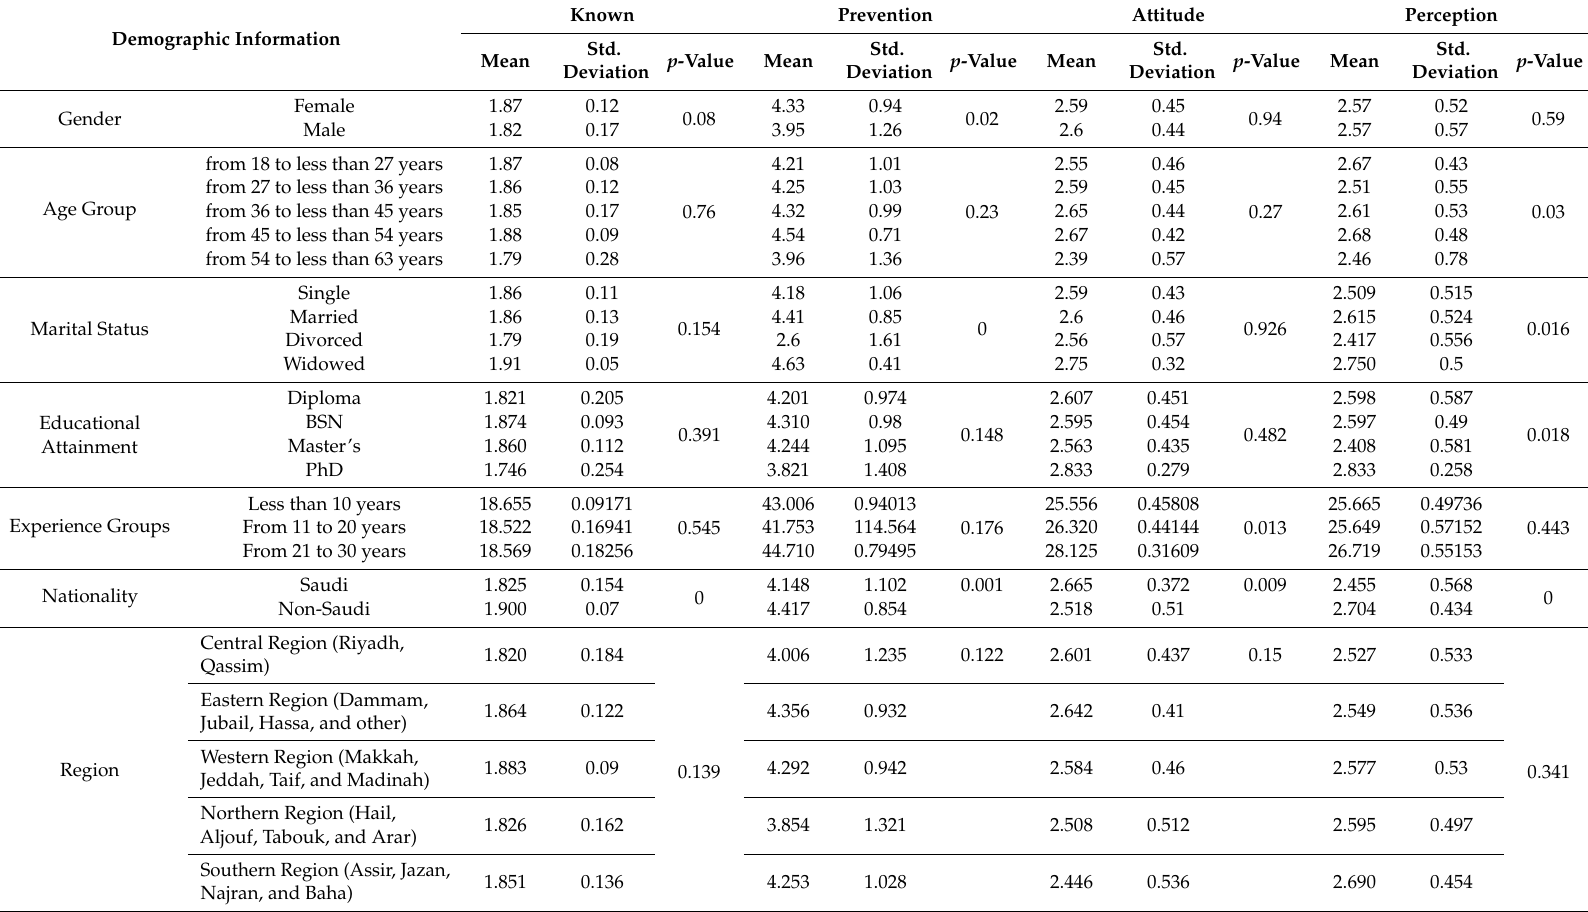
Table 3. Association between nurses’ demographic information and their awareness, attitude, and perceptions of the COVID-19 outbreak ( n = 500). Demographic